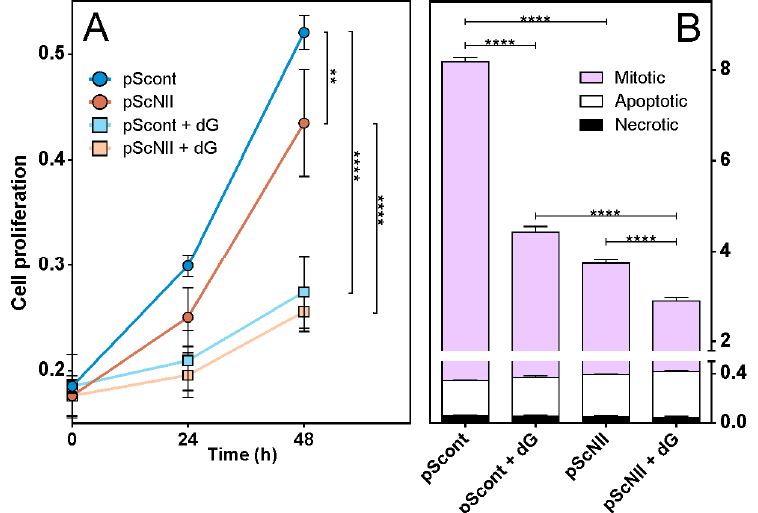
Figure 3. A549 cell proliferation and viability. ( A ) A549 pScont and pScNII growth with or without 20 mM dG was monitored at 24 and 48 h, measuring the absorbance at 596 nm of cells stained with crystal violet. Data are the mean + SEM of two experiments performed in sextuplicate; ( B ) the percentage of mitotic, apoptotic and necrotic cells at 24 h of growth is reported. Results are the mean + SEM of three independent experiments. ** p < 0.01, **** p < 0.0001. Statistical analysis in A gave the same results after 24 h of culture.